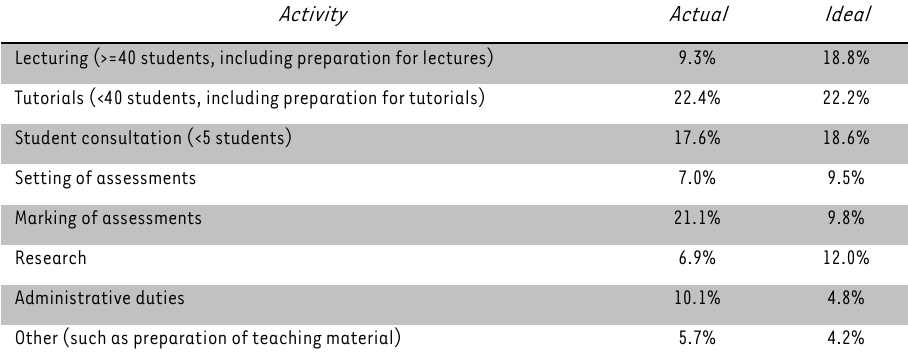
Comparison between actual time and ideal time spent on academic activities (percentage of total time)